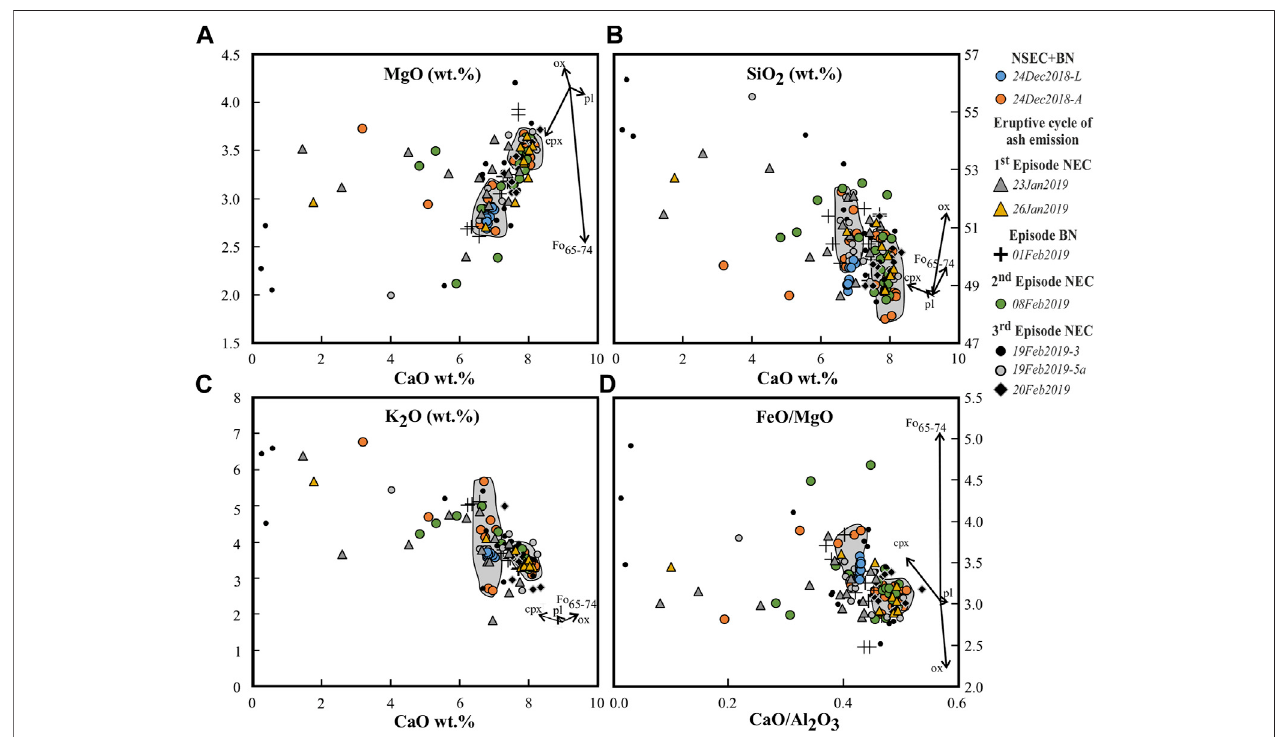
FIGURE 11 | Groundmass glasses composition of studied samples. Within each diagram, the arrows represent a subtraction of 5% of the correspondent mineral phasestartingfromtheglasscompositionofanashfragmentfromthe 24Dec2018-Asample characterizedbyCaO=8.13wt.%,MgO=3.59wt.%,SiO 2 =49.25wt.%, K 2 O = 3.26 wt.%, CaO/Al 2 O 3 = 0.49, and FeO/MgO = 2.96. The grey fi elds identify low-CaO (CaO = 6.9 ± 0.3 wt.% and MgO = 3.5 ± 0.2 wt.%) and high-CaO (CaO = 7.8±0.2wt.%andMgO=2.9±0.3wt.%)compositionalgroupsrecoveredinthe 24Dec2018-Asample .cpx=clinopyroxene;ox=oxide;pl=plagioclase;Fo 65-74 corresponds to olivine with two different Forsteritic